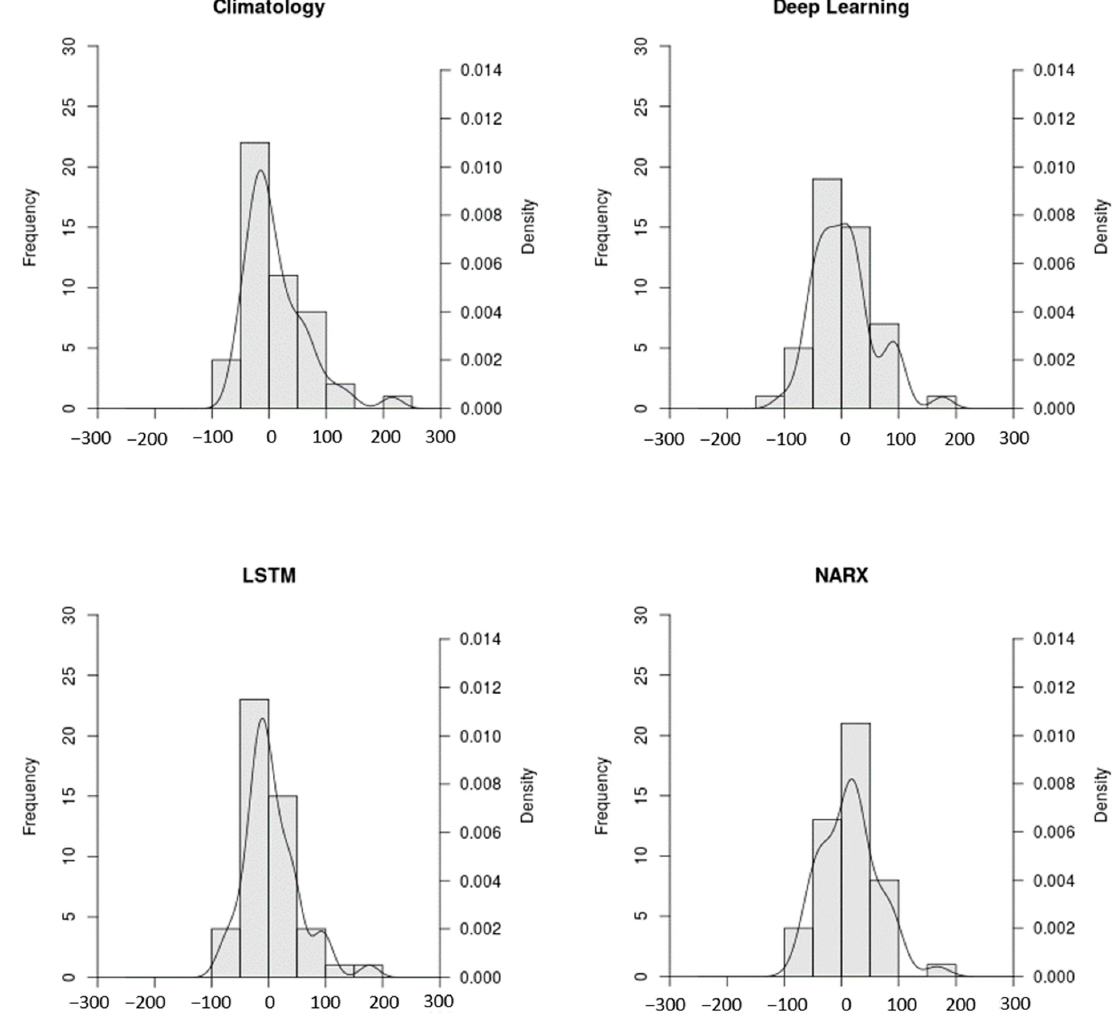
Figure 6. Error histogram of Group 3 models and climatology for a forecast horizon of 1 month for the Guavio reservoir.